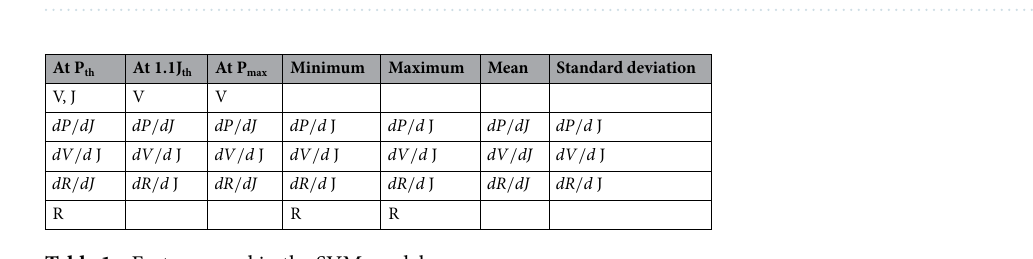
Figure 2. Current density versus voltage (left) and current density versus optical power (right) characteristics for the nine devices. After burn-in, the devices that were still functional are denoted with G1, G2, G3, G4 and G5, whereas defective devices are denoted as B1, B2, B3 and B4. Device condition identification by eye is not apparent.